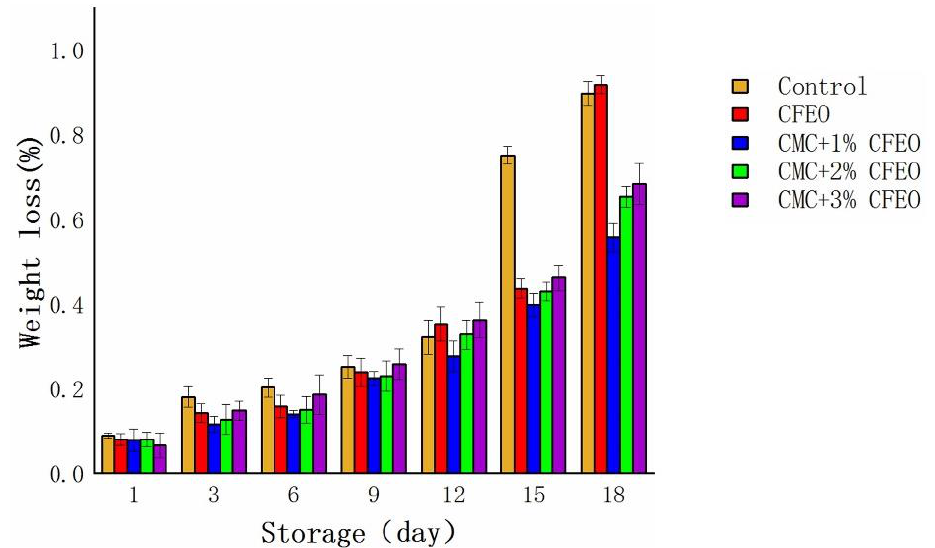
Figure 9. The effect of different treatment groups on weight loss of Shine Muscat grapes.